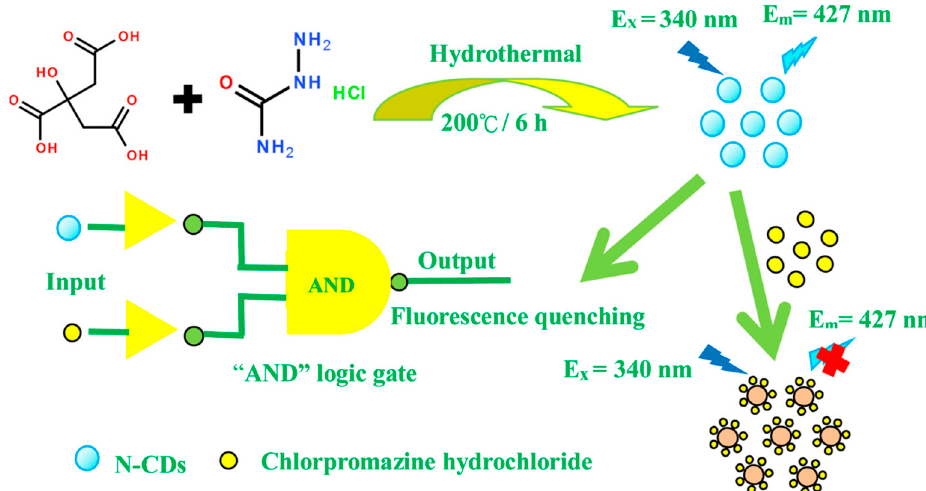
Figure 7. Schematic diagram of the formation process of N-CDs and detection for chlorpromazine hydrochloride (CPH). Reproduced from ref [70] with permission of the Journal of Photochemistry and Photobiology A: Chemistry copyright 2019.